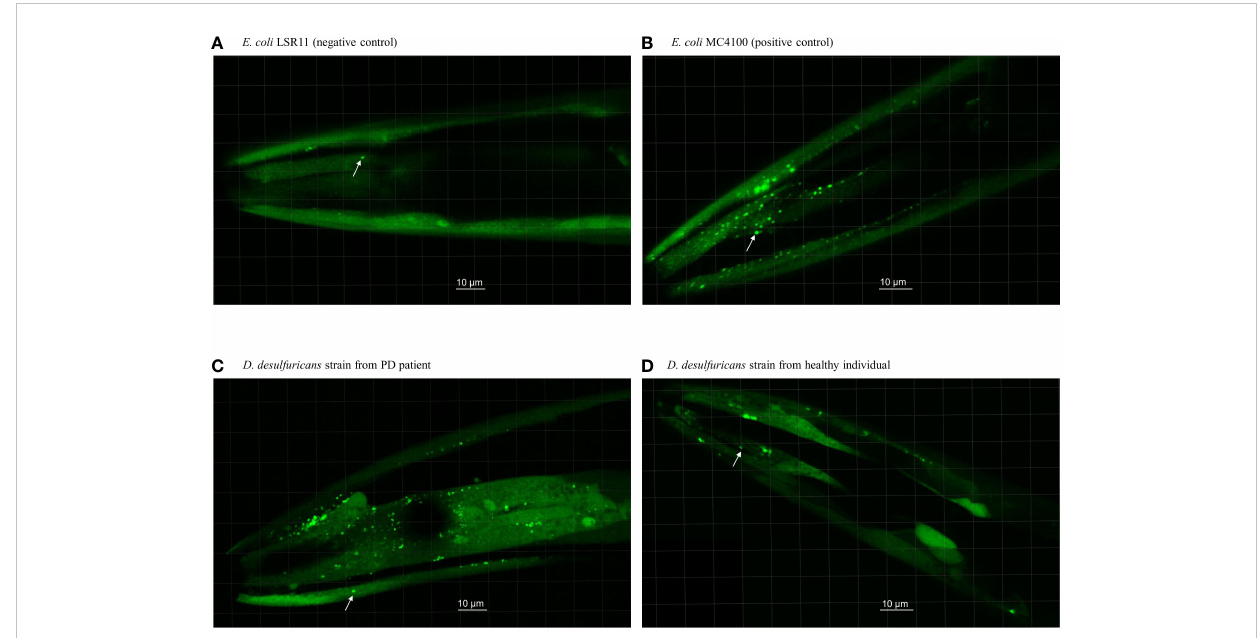
FIGURE 1 Head section of C. elegans worms fed with E. coli controls and Desulfovibrio bacteria from patients with Parkinson ’ s disease and healthy individuals. Worms were fed with (A) E. coli LSR11 (negative control), (B) E. coli MC4100 (positive control), (C) D. desulfuricans strain from PD patient and (D) D. desulfuricans strain from healthy individual. The arrows indicate some of the alpha-syn aggregates. The aggregates in worms fed with DSV bacteria from the PD patients were brighter, larger, and more abundant than the